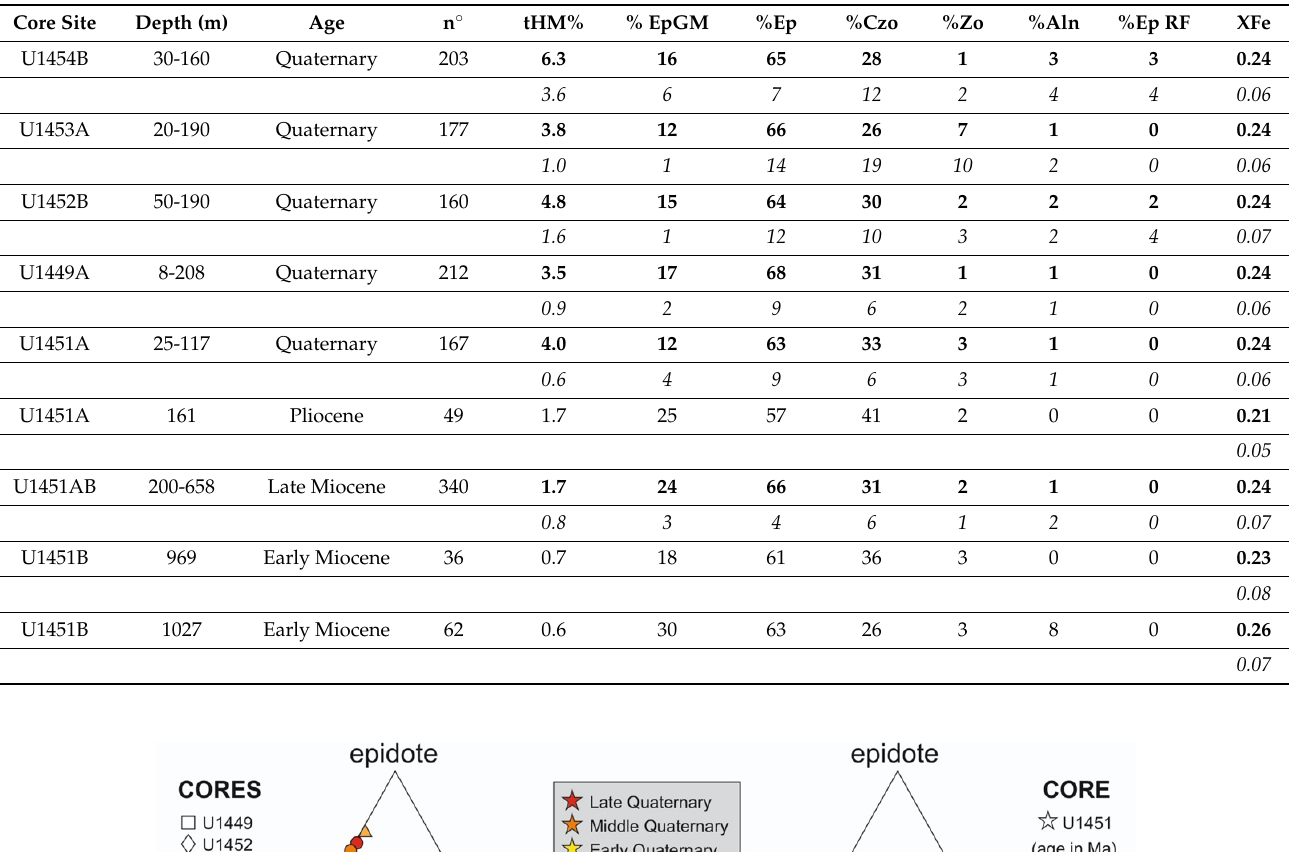
Table 2. Average composition of detrital epidote group minerals in turbidites of different ages from the five studied Bengal Fan cores, as determined using the new Raman library ( mean in bold, standard deviation in italics); n°, number of analyzed grains; tHM, transparent heavy minerals; EpGM, epidote group minerals; Ep, epidote; Czo, clinozoisite; Zo, zoisite; Aln, allanite; RF Ep, epidote-bearing rock fragments.